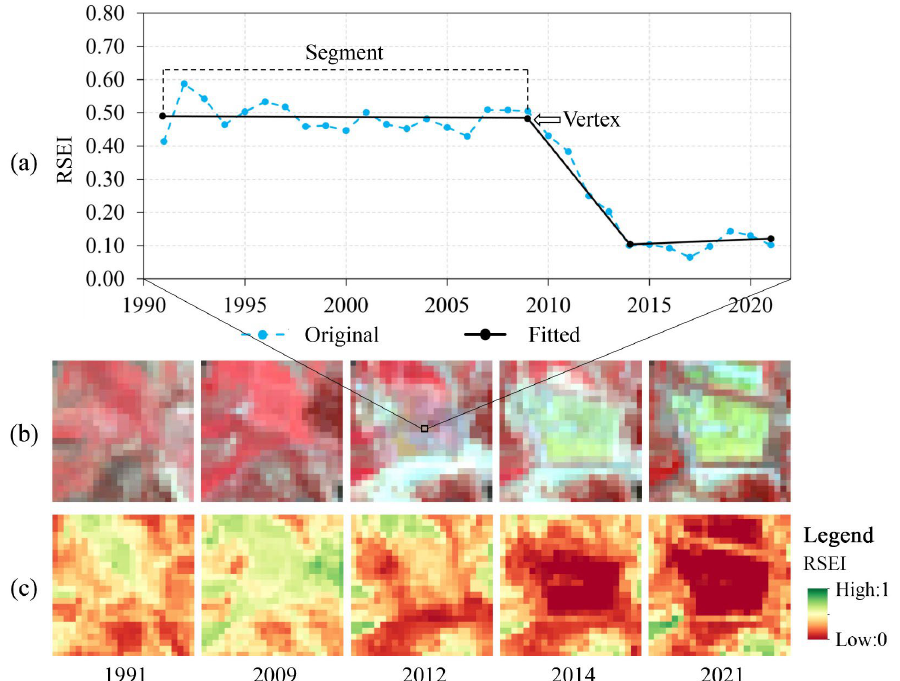
Figure 3. Example of LandTrendr’s segmentation and fitting of time series remote sensing-based ecological index (RSEI). ( a ) a line chart with the selected point, original RSEI values, and corresponding fitted values; ( b ) example of land cover type change at corresponding positions in Landsat images; ( c ) example of RSEI change in corresponding years.